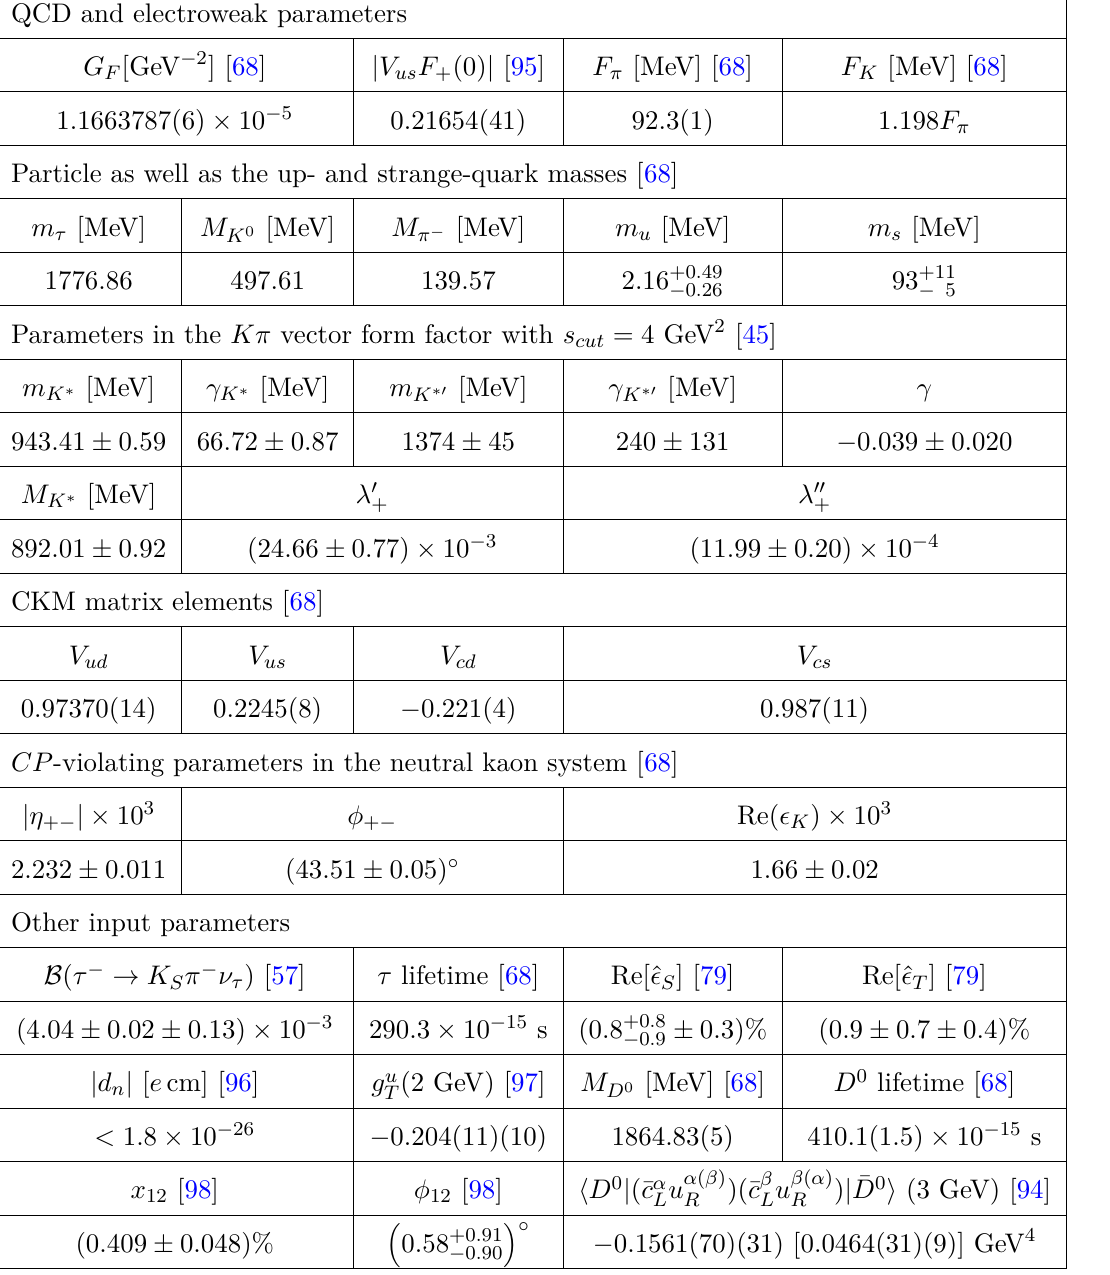
Table 1 . Summary of the input parameters used throughout this work. The up- and strange-quark masses are given in the MS scheme at the scale µ = 2 GeV [68]. The hadronic matrix elements of ∆ C = 2 four-fermion operators contributing to the D 0 − ¯ D 0 mixing are evaluated in the MS -NDR scheme at the scale µ = 3 GeV